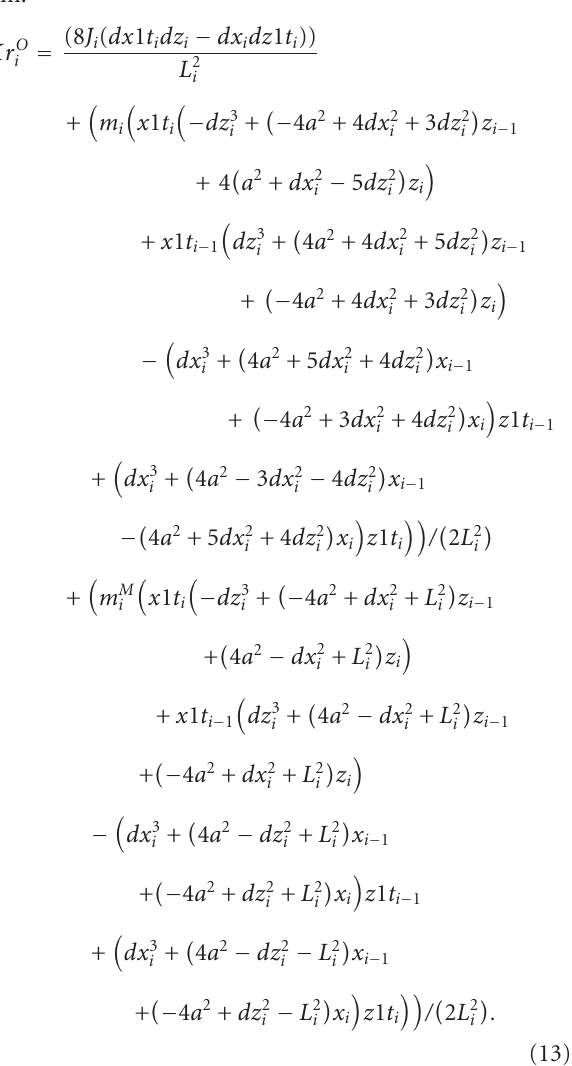
For i th gyro-damper 1,2). The transformation matrix T c gd ( i ) has the